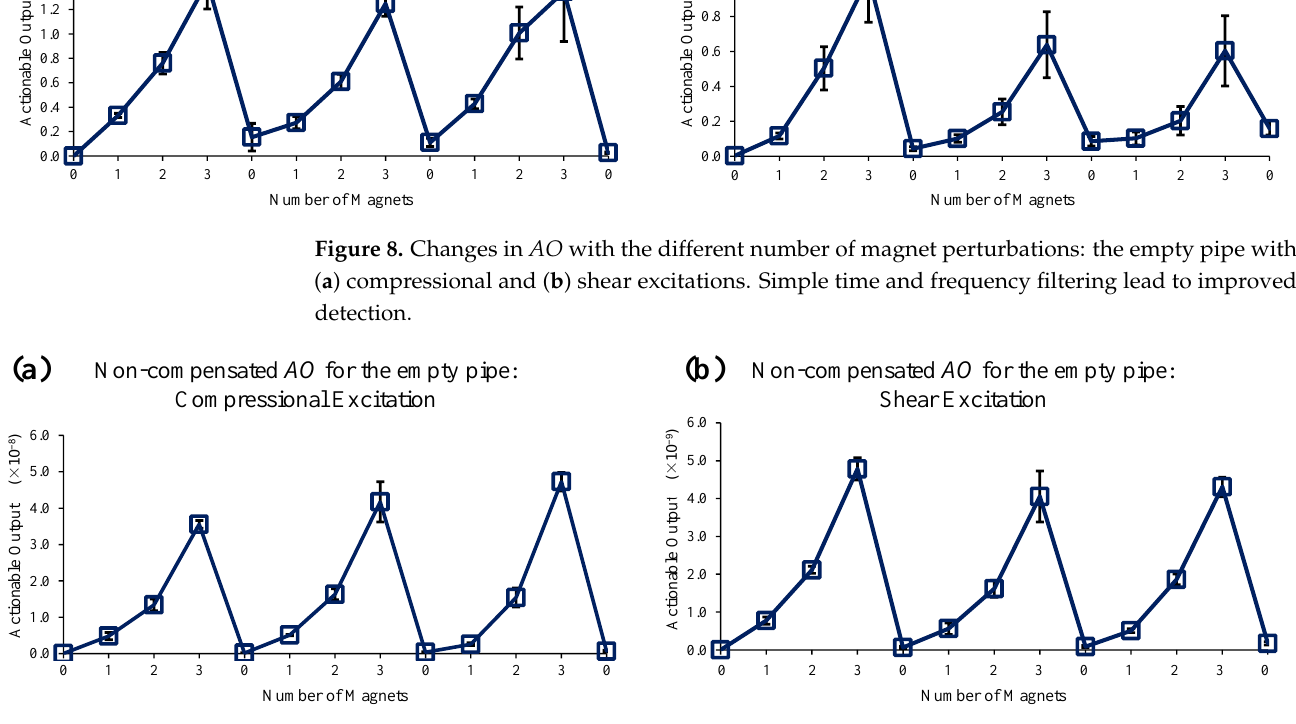
Figure 9. Changes in AO with the different numbers of magnet perturbations for the empty pipe with ( a ) compressional and ( b ) shear excitations. No EOC compensation is applied.